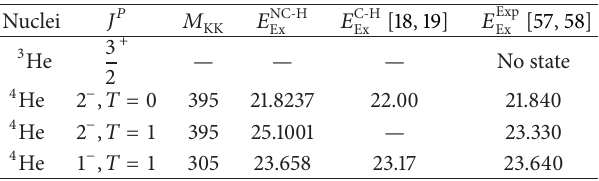
Table 8: The obtained excited energy of 3 He and 4 He nuclei with = 3 and 𝑚 = 0.92 GeV. The results have a good agreement with 𝑁 𝑐 𝑁 the experimental nuclear data [57, 58]. All energies are in